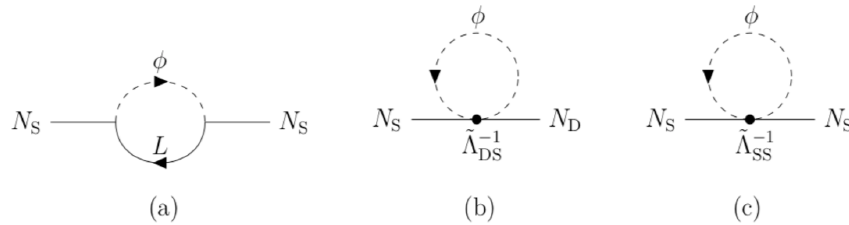
Figure 1 . Self-energy diagrams from Yukawa interactions (panel (a)) and from Anisimov interac- tions (panels (b) and